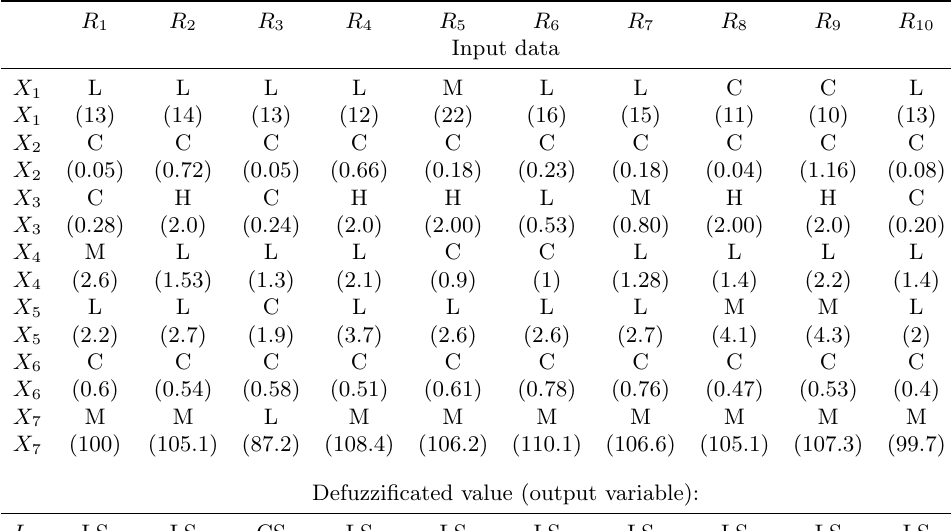
Table 8: Results of economic security